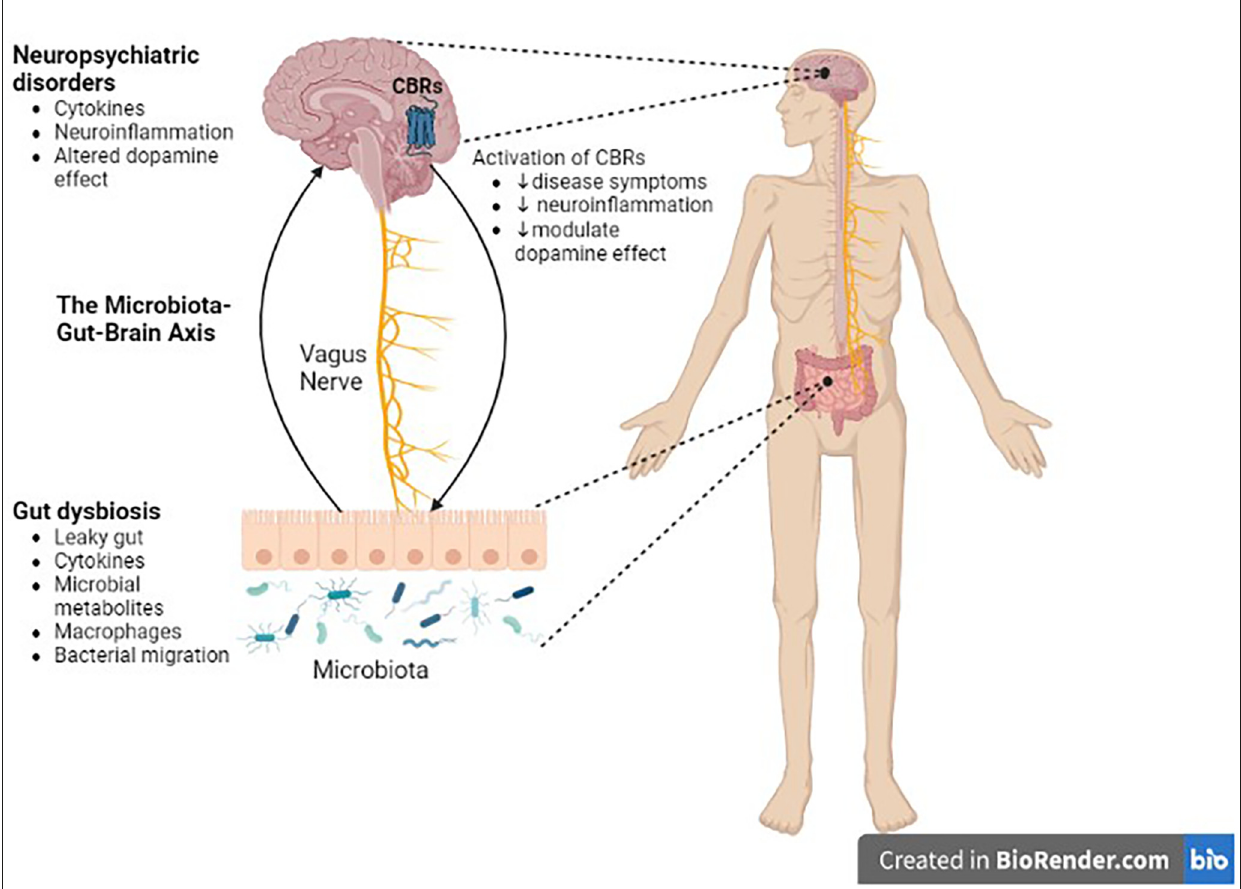
FIGURE4 Role of the microbiota-gut-brain axis in CNS disorders. There is a bidirectional communication between the gut microbiota and the brain through the vagus nerve. Gut dysbiosis may play a crucial role in neural development, neurotransmission, neuroinflammation, and changes in neurotransmitter function, which in turn contribute to the pathogenesis of neuropsychiatric, and neurodegenerative diseases. Cannabinoid ligands targeting central cannabinoid receptors might be used in the treatment of Parkinson’s disease, drug addiction, or schizophrenia. CBRs, cannabinoid receptors.